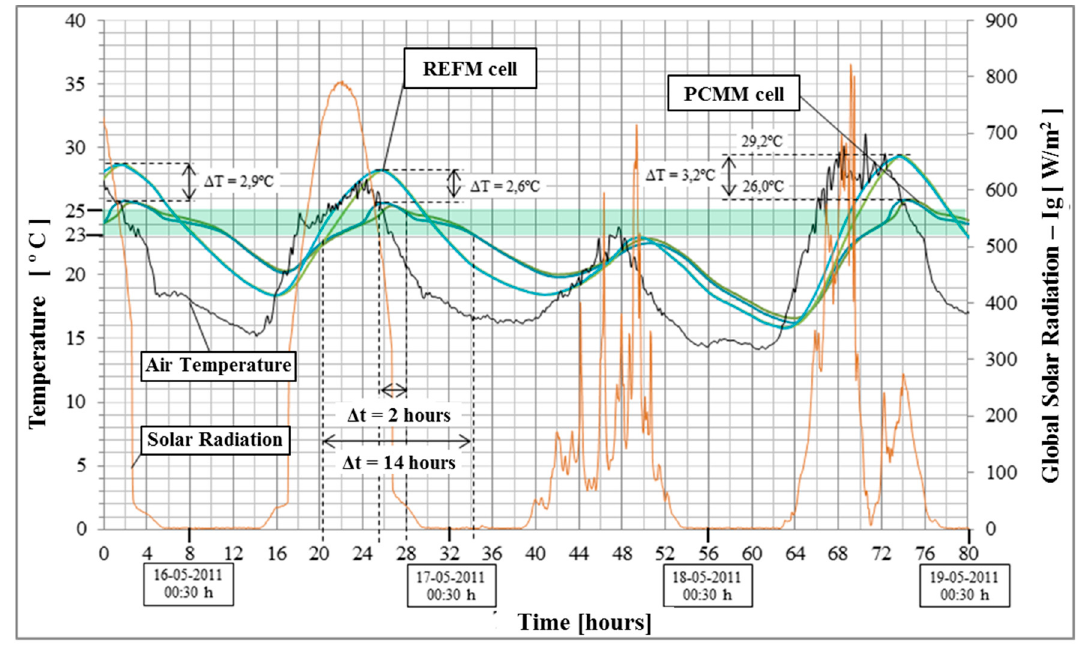
Figure 8. Experimental results of exterior temperature, global solar radiation and temperature inside the cells (SE corner and cover).